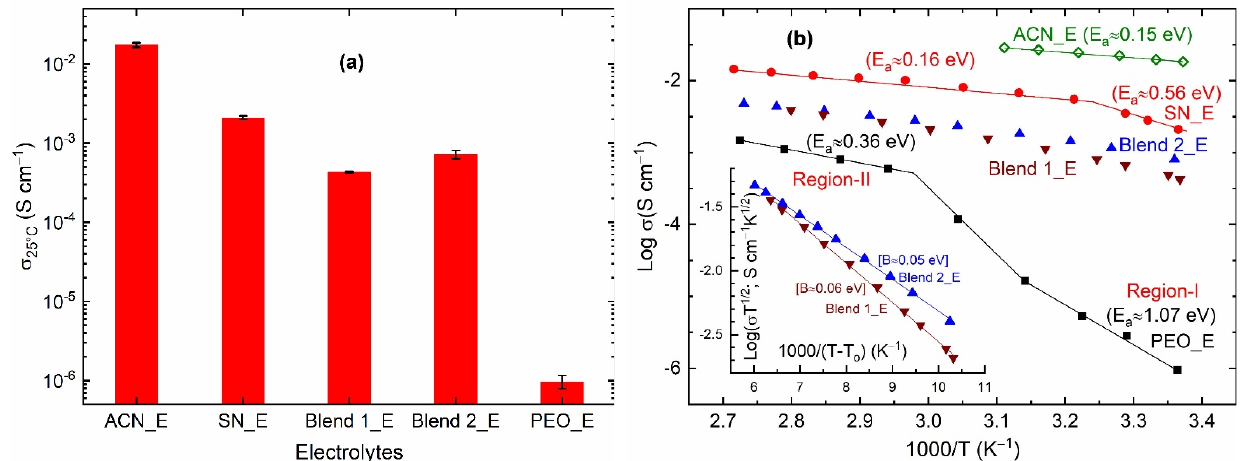
Figure 3. ( a ) Electrical conductivity ( σ 25°C ) and ( b ) log σ vs. T − 1 plots of the solid redox mediators, ACN_E, SN_E, PEO_E, Blend 1_E, and Blend 2_E. Inset in ( b ) is VTF plots of Blends 1_E and 2_E.